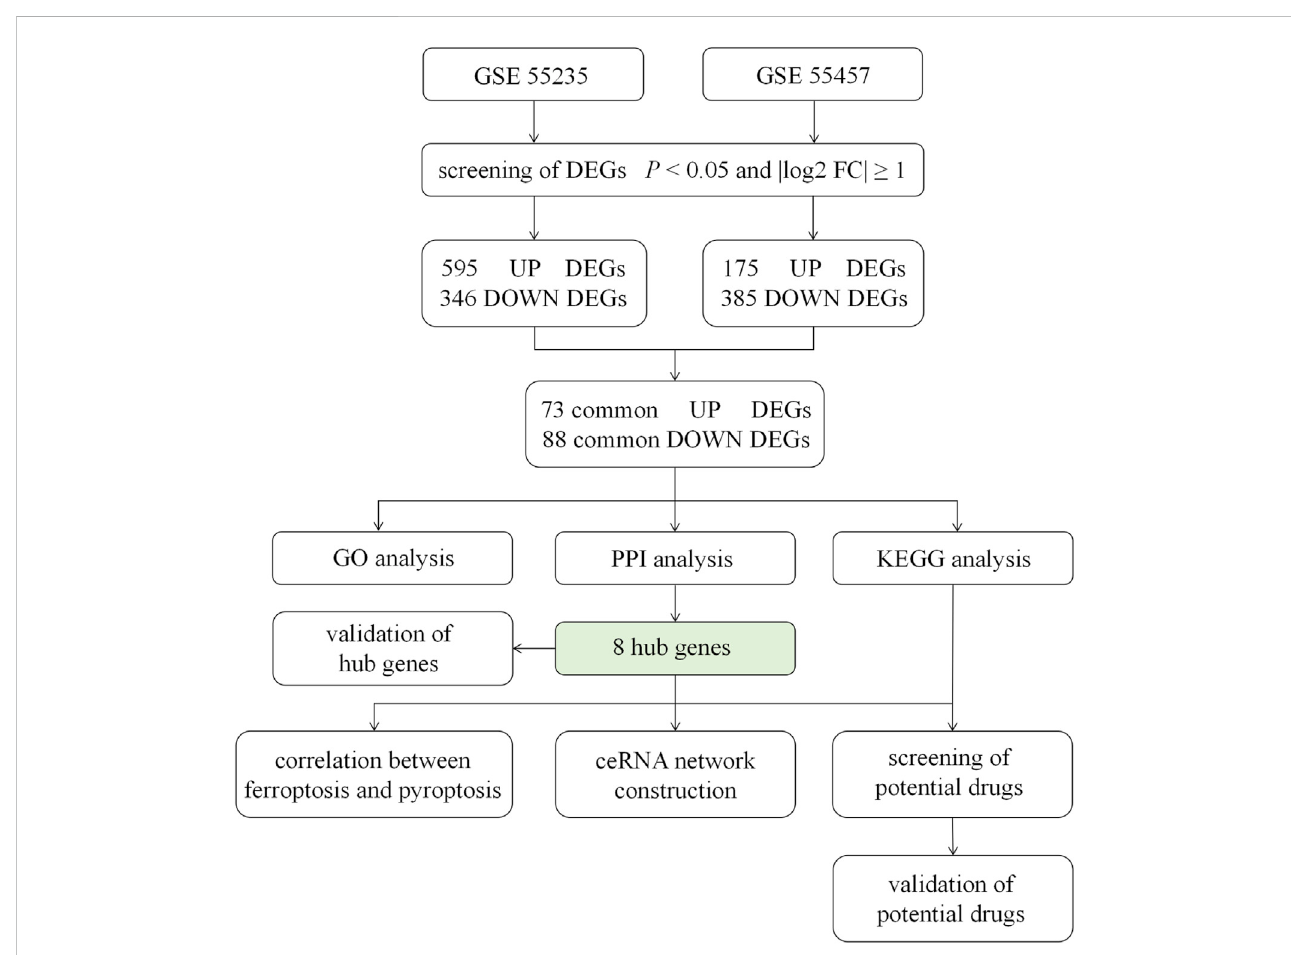
FIGURE 1 Flowchartofthestudydesign.GSE55235,GSE55457weredeterminedasthedatasetsofthisstudy,fromwherewescreenedDEGsbythestandardof p < 0.05 and log2|FC| ≥ 1. After the intersection, 71 up-regulated DEGs and 88 down-regulated DEGs were obtained, followed by GO analysis, PPI network construction and KEGG pathway analysis. The correlation between hub genes and ferroptosis or pyroptosis and the construction of ceRNA were undertaken. Moreover, the expression of 8 hub genes was validated. Finally, potential drugs targeting pathways and hub genes were identi fi ed and validated. DEGs = differentially expressed genes; FC = fold change; GO = gene ontology; PPI = protein - protein interaction; KEGG = Kyoto Encyclopedia of Genes and Genomes; ceRNA = competing endogenous